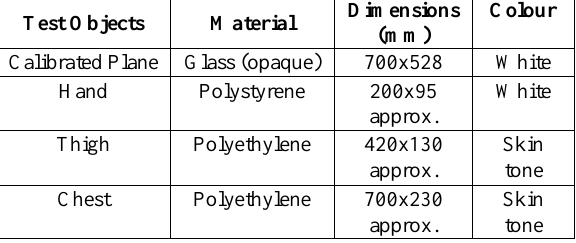
Table 2. Objects used in this project with material, dimension and colour